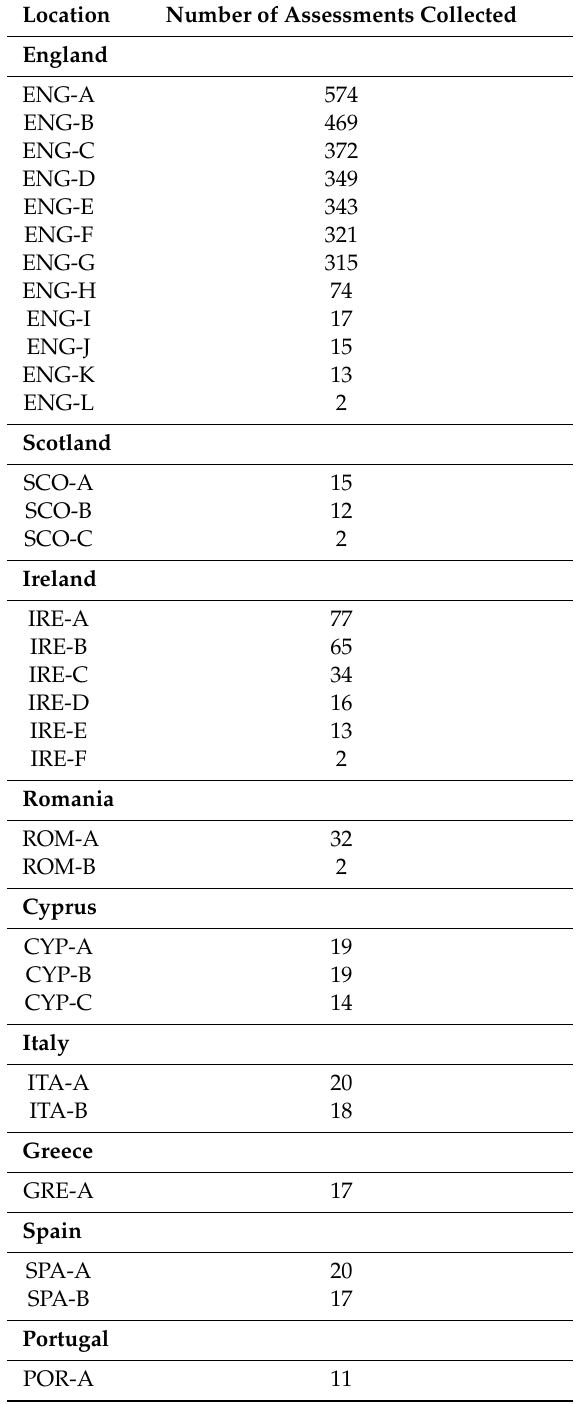
Table 6. Number of assessments collected using the TDS Farms protocol, listed by country and site.